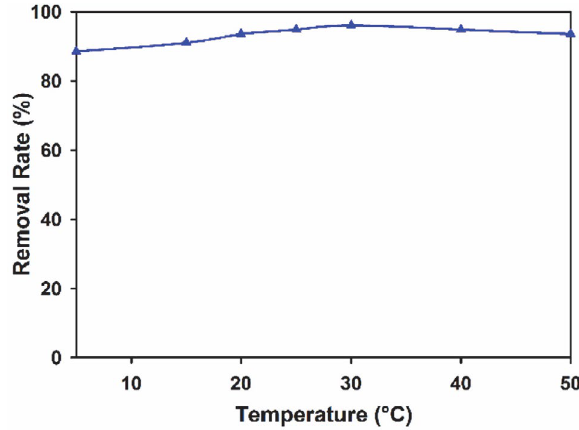
Figure 10. The effect of solution temperature on the bioreactor per- formance.